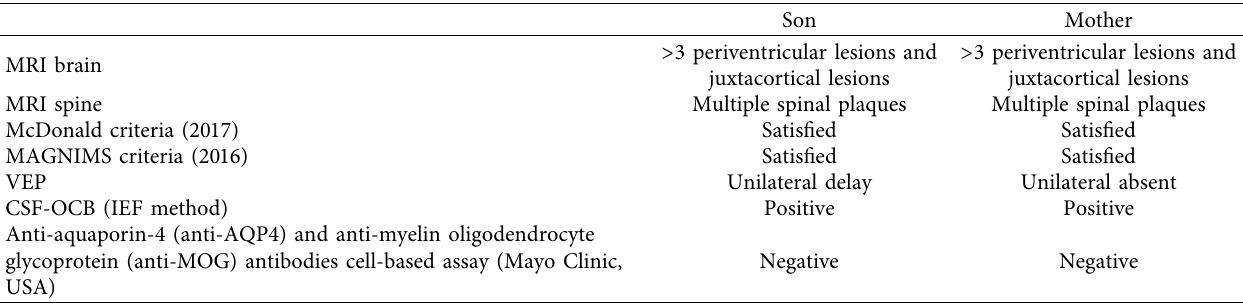
Figure 3: T2 FLAIR axial (a, b) and T2 axial (c) show multiple periventricular Dawson’s fingers and juxtacortical lesions. Significant cerebral atrophy is seen with enlarged lateral ventricles suggesting chronic disease. T2 sagittal images of the cervical and upper dorsal spine (d) show multiple short segment lesions without significant cord expansion. Table 1: Summary of